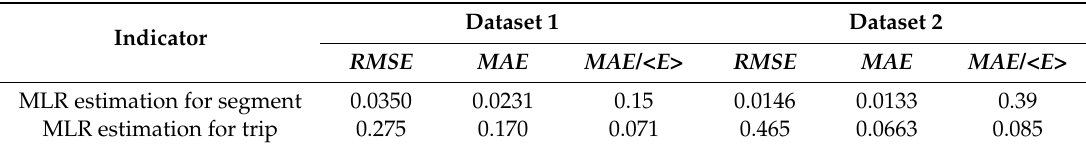
Table 6. Performance indicators MLR energy estimation model on trip and segment level by considering the measured CMF and aerodynamic predictor as